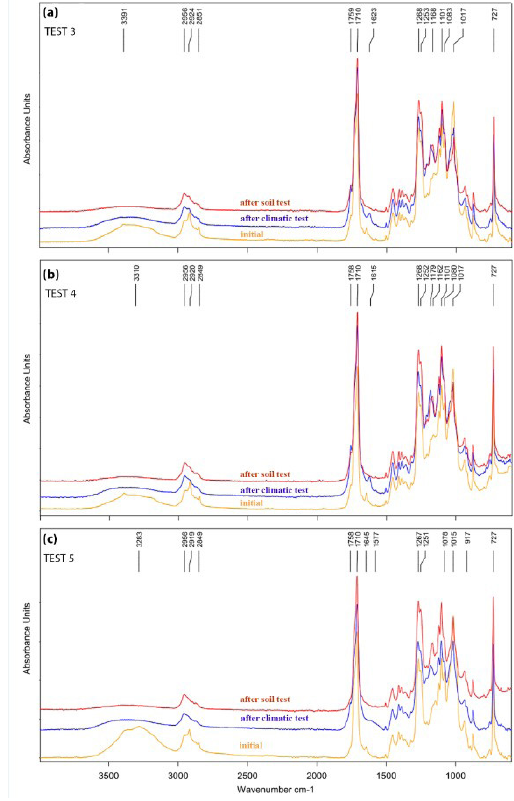
Figure 4. FTIR spectra of REF 1 (a), TEST 1 (b), and TEST 2 (c) samples after the biodegradation test in soil and after the climatic test compared to the initial samples.